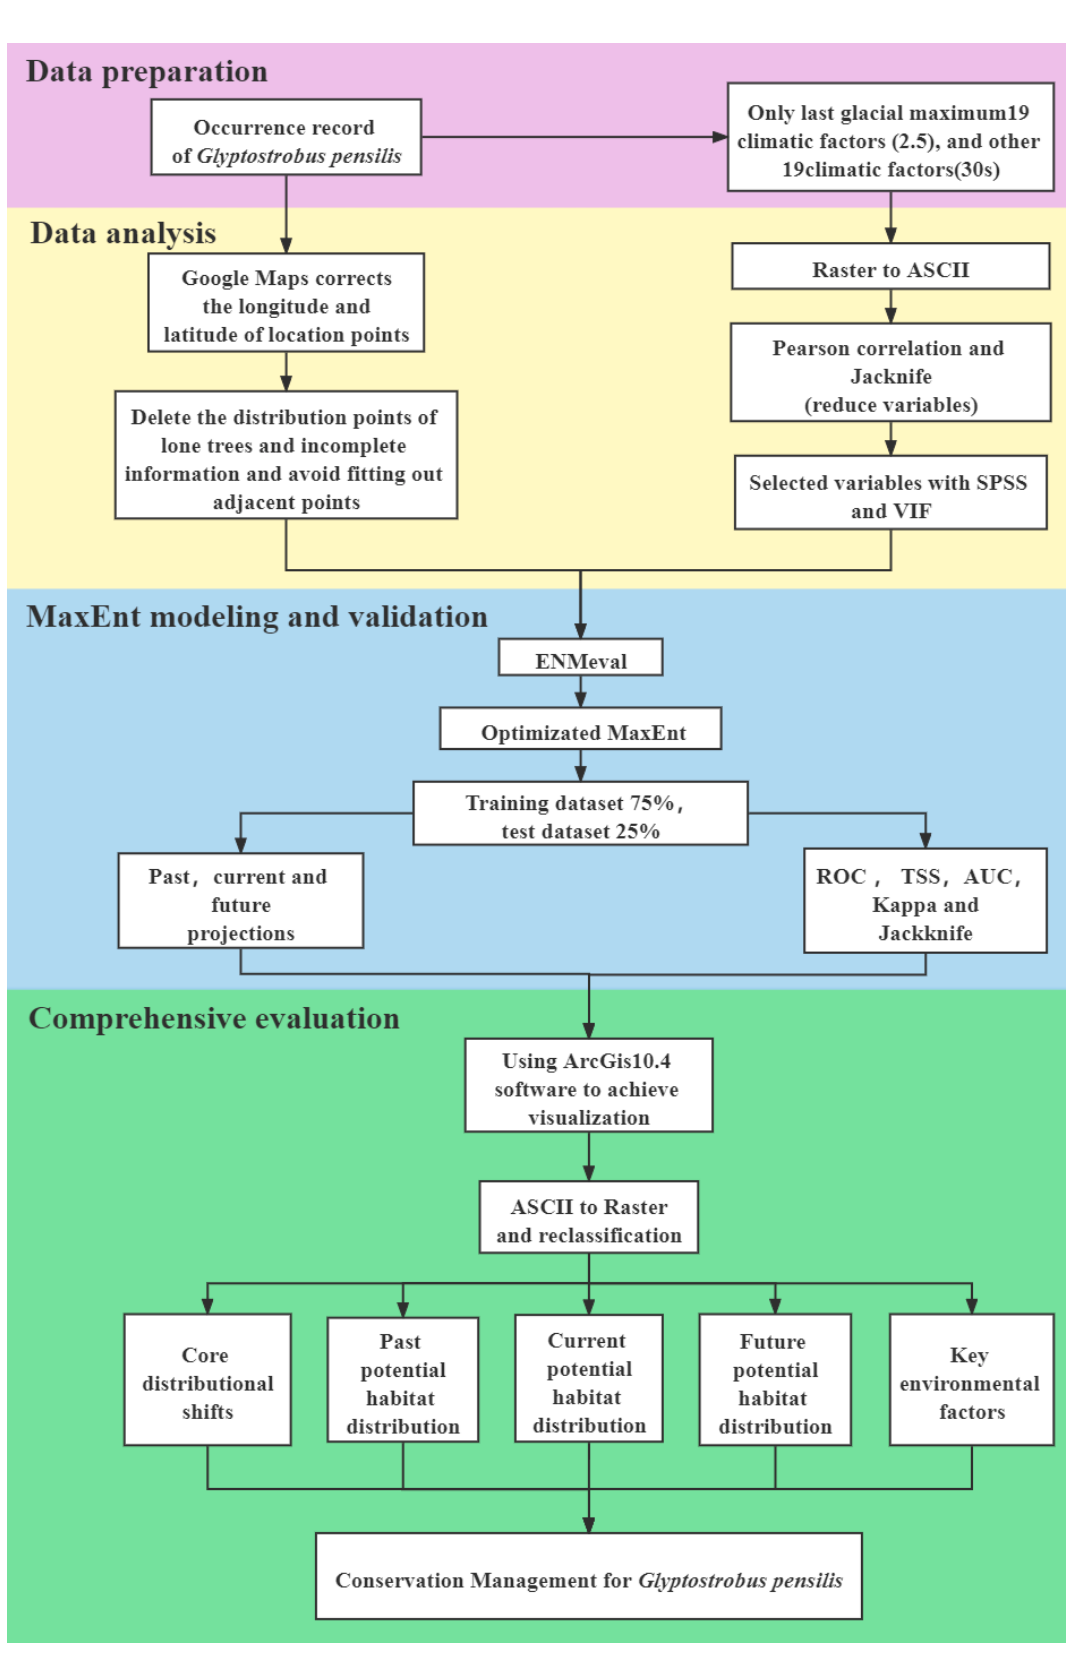
Figure 3. Processing methodology in flow diagram in this